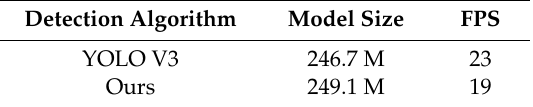
Table 8. The comparative results of FPS and model size with YOLO V3 and improved YOLO V3.